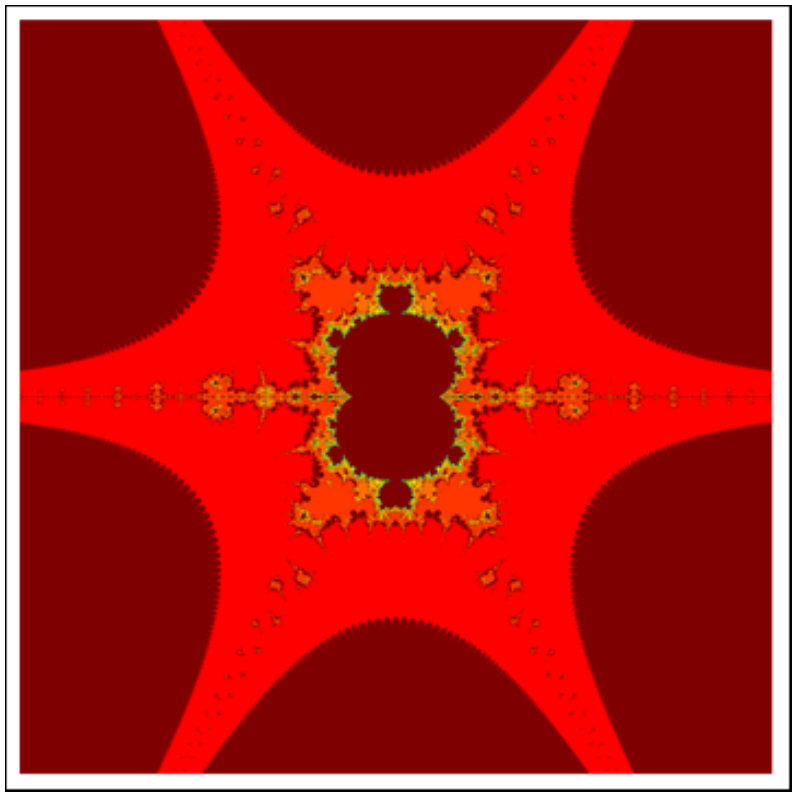
Figure 23. M-set for τ ( z ) = sin ( z 3 ) + c via DKIS. The image execution time is 998.313